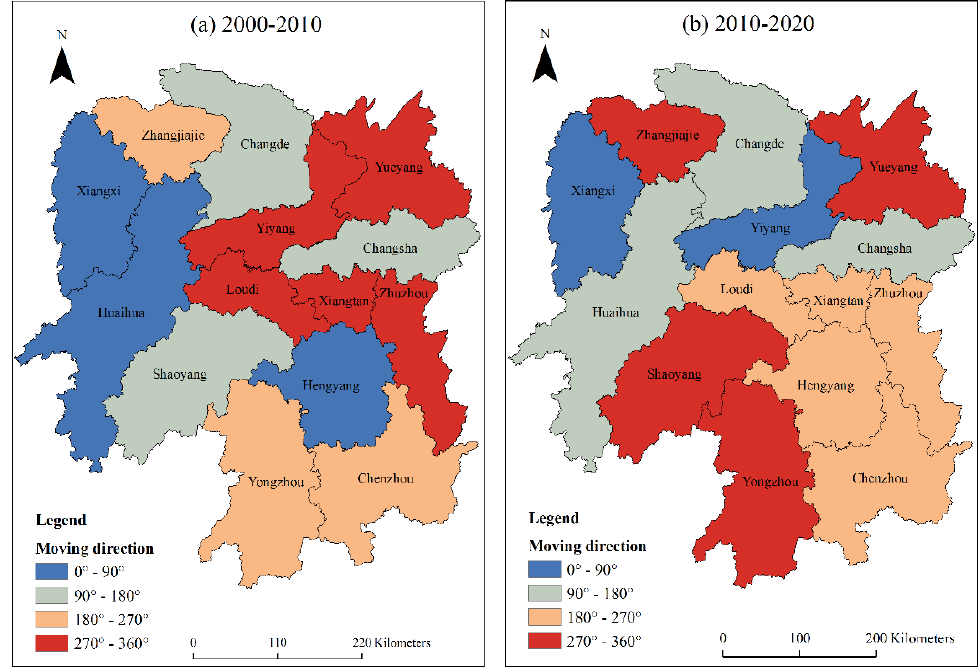
Figure 6. Spatial distribution of average movement direction of the LISA time path from 2000 to 2020.